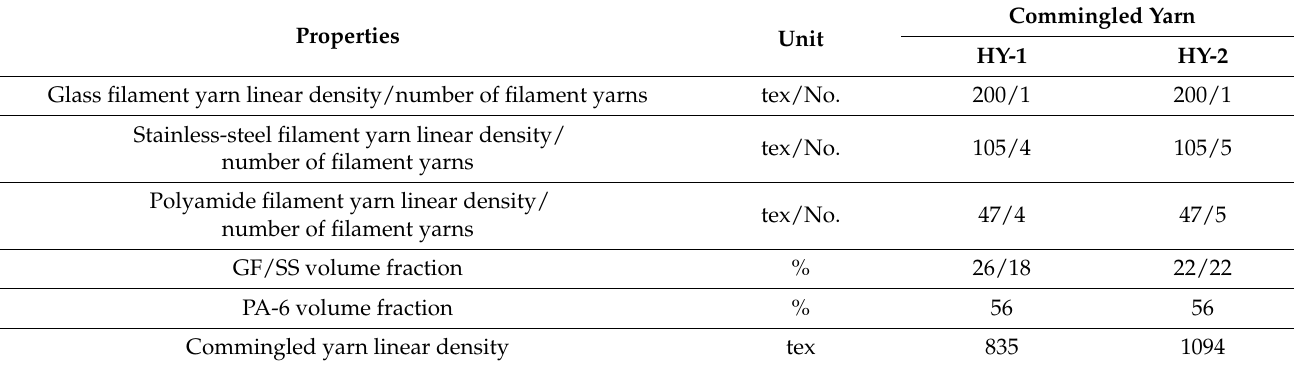
Table 1. Properties of the raw materials.